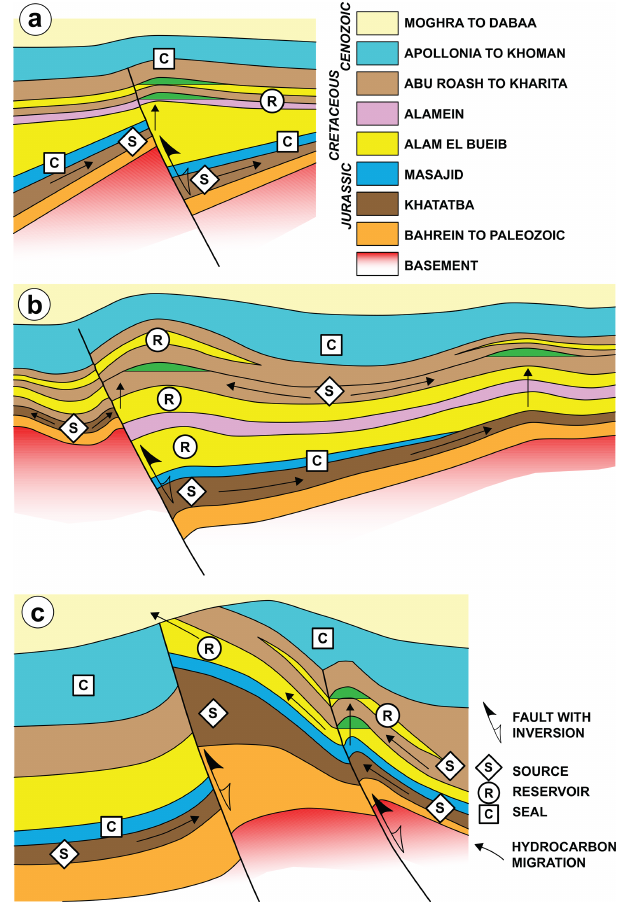
Figure 15. Cartoons of potential charge scenarios of structures asso- ciated with inversion structures, redrawn from Bevan and Moustafa (2012). These examples from the Western Desert of Egypt illus- trate well the increasing severity of inversion with the correspond- ing variations in the petroleum system migration patterns. The three progressive stages are shown using the oil field examples of (a) Raz- zak, (b) Mubarak and (c) Kattaniya. See text for a generalization of the impact of inversion tectonics on petroleum systems and explo- ration